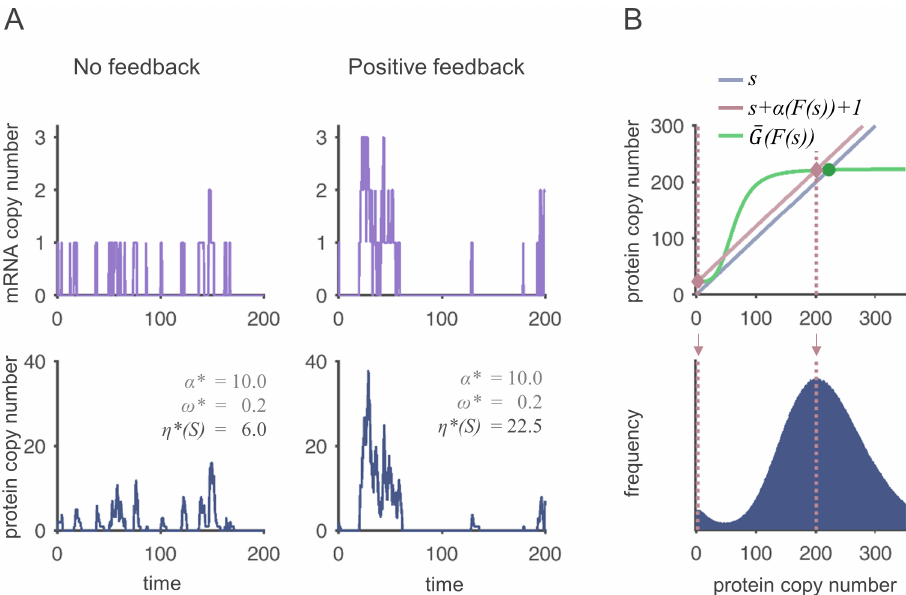
Fig 4. Protein bursts cause peaks in protein time courses and skewed protein distributions. (A): mRNA (upper plots) and corresponding protein time courses (lower plots) of reaction systems without (left) and with (right) positive feedback. The average burst sizes and frequencies are identical in the two systems, but the transcription events are temporally clustered under positive feedback, leading to rare super-bursts. The functions used are F ( s )= a + v (cid:1) s and G ( m )= g (cid:1) m with a = 0.2 and v = 0 in the system without feedback and a = 0.05 and v = 0.075 in the system with feedback. In both cases, g = 10 and ν = 1. (B): The upper plot shows the graphical determination of the location of modes. Two modes are predicted in the monostable system (modes: rose diamonds, fixed point: green filled circles). The protein distribution in the lower figure shows that the prediction is exact. Here, F s ð Þ ¼ 7 = 600 þ 0 : 1 (cid:1) s 4 G ( m )= 2000 (cid:1) m , ν =